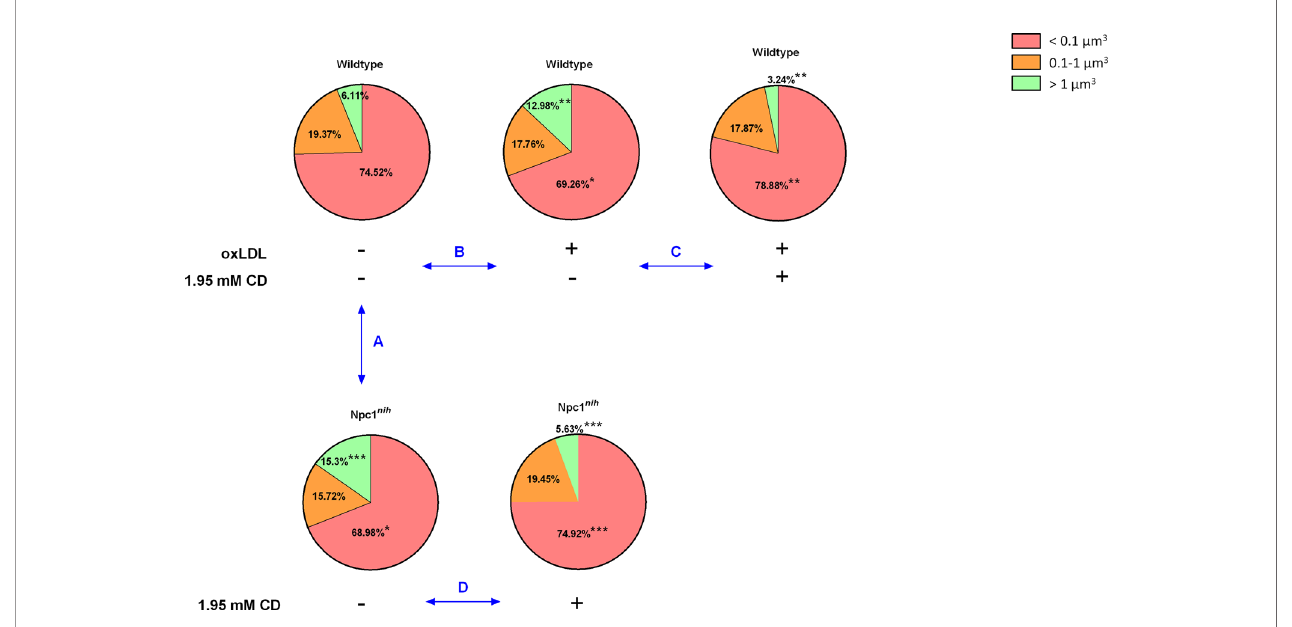
FIGURE 3 | Lysosomal volume of metabolically-challenged bone marrow-derived macrophages with and without intervention. We quanti fi ed the number of lysosomes, categorized them by size (< 0.1 µm 3 ; 0.1-1 µm 3 ; > 1 µm 3 ) and expressed the number of lysosomes per size relative to the total amount of lysosomes present inside the BMDM. Comparison A : Relative comparison of the distribution of lysosomal volumes between Wt and Npc1 nih BMDM. Comparison B : Relative comparison of the distribution of lysosomal volumes between control and oxLDL (25µg/ml; 72hr) -stimulated Wt BMDM. Comparison C : Relative comparison of the distribution of lysosomal volumes between oxLDL-stimulated Wt BMDM treated with or without CD (1.95 mM; 4hr). Comparison D : Relative comparison of the distribution of lysosomal volumes between Npc1 nih BMDM treated with or without CD. *, ** and *** indicate p < 0.05, 0.01 and 0.001 resp.by means of unpaired t- test. Data are the result of analysis of n = 5-7 BMDM per experimental